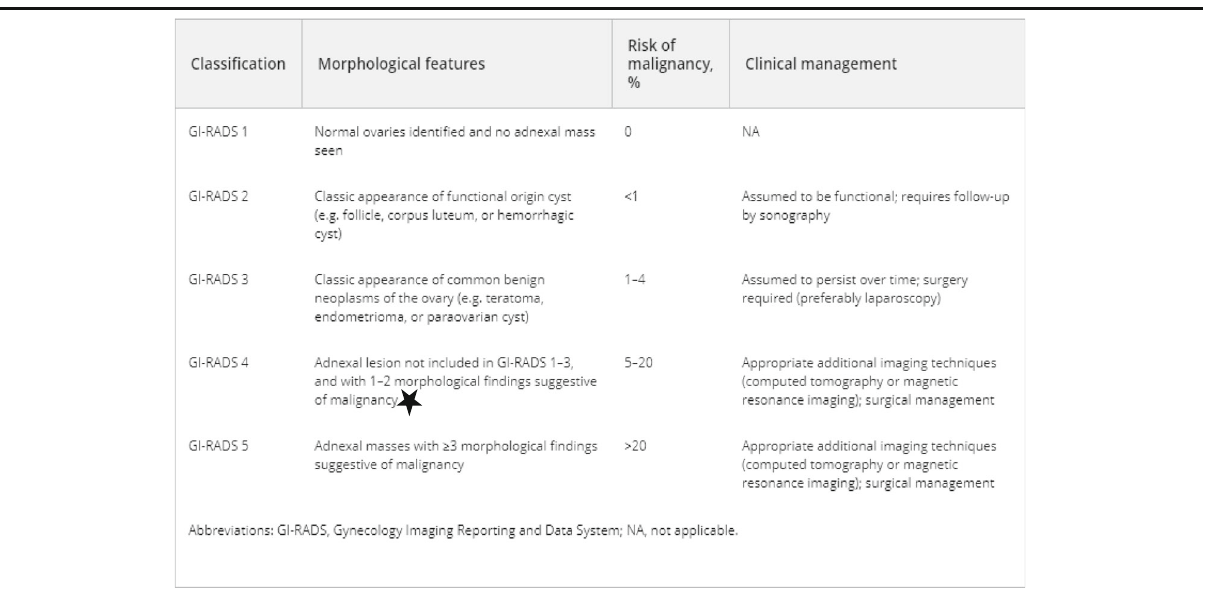
Table 1 The GI-RADS classifications [3]